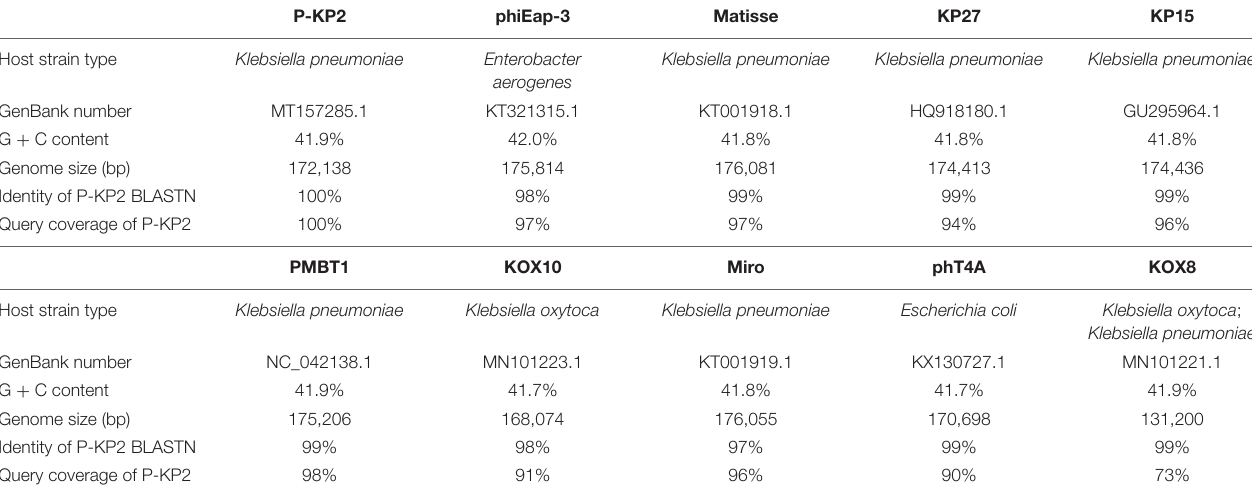
TABLE 1 | Global genome comparison of P-KP2 with homologous